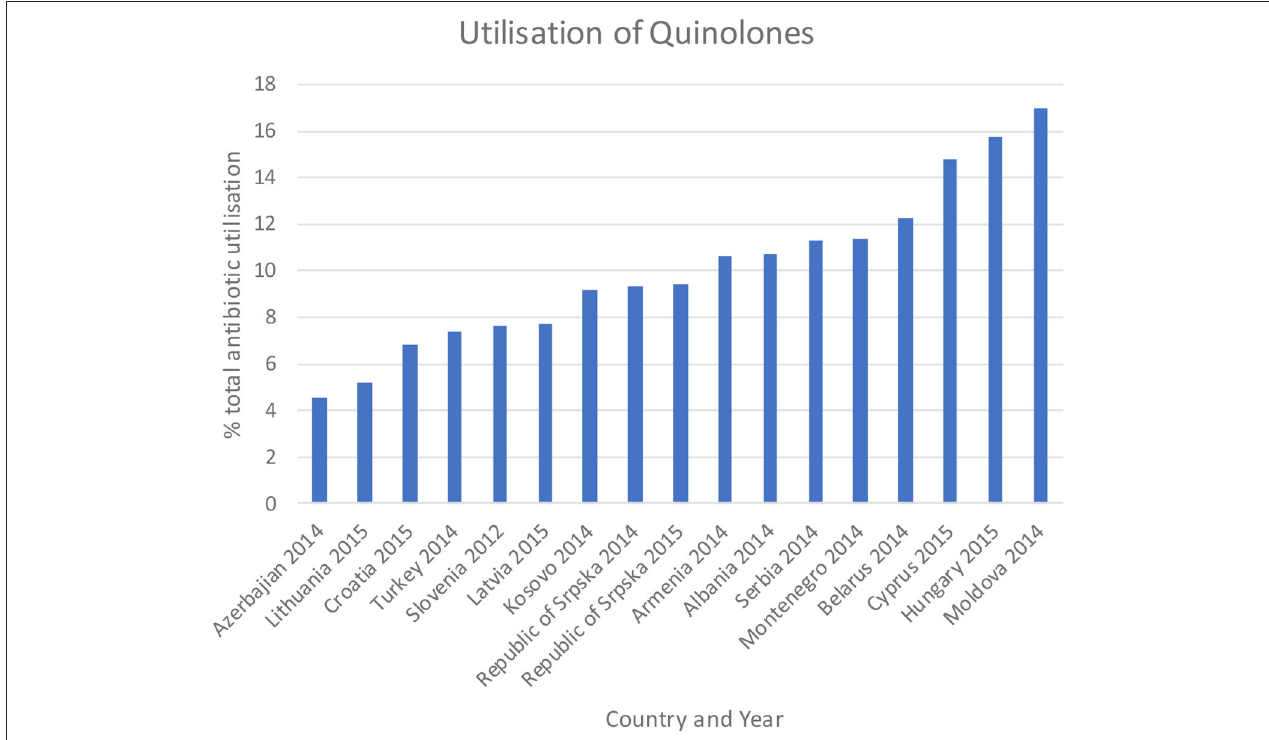
FIGURE 4 | Utilization of quinolones as a % of total antibiotic utilization across countries (taken from Fürst et al., 2015; WHO EUROPE, 2017; ECDC, 2018).